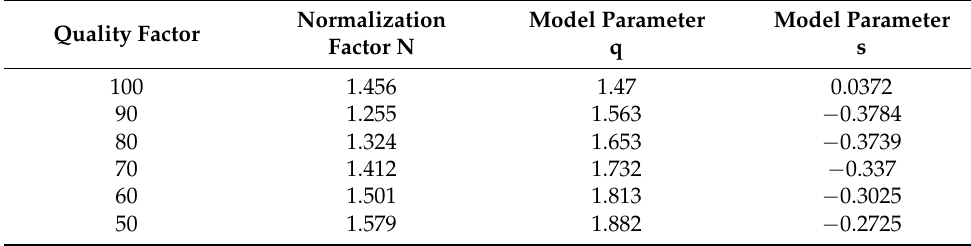
Table 1. Proposed normalization factor and model parameters. Quality